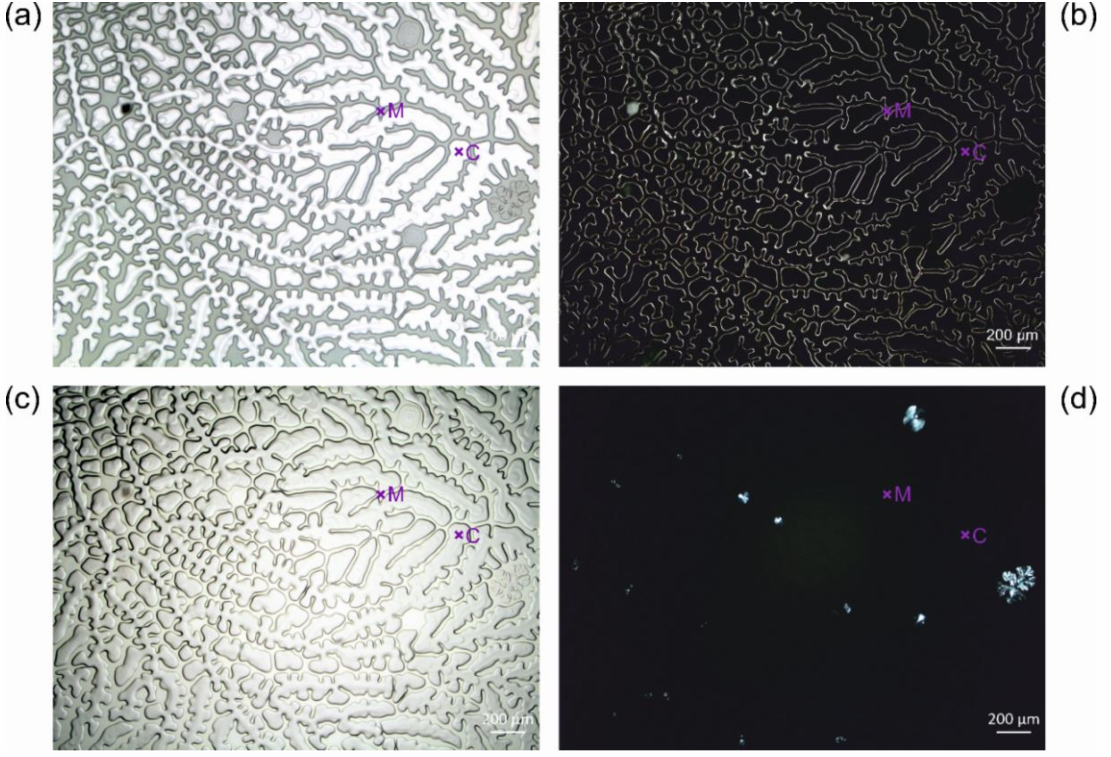
Figure 16. Light micrographs of cavities in an unknown mounting medium, sample USNM 1226589, Cateria styx : ( a ) reflected light brightfield, ( b ) reflected light darkfield, ( c ) transmitted light micrograph with parallel, and ( d ) crossed polarisers. According to the assignments derived from the micropectroscopic maps shown in Figure 18e–g, ‘M’ and ‘C’ exemplarily mark medium and caverns,